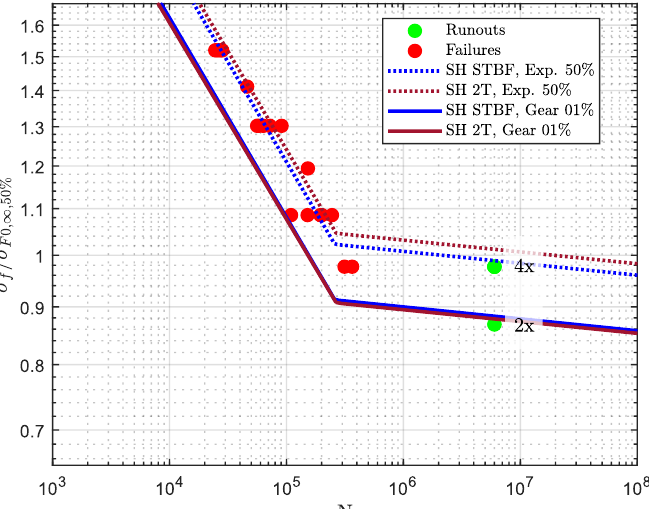
Figure 8. Evaluation of SN curves with different failure probabilities for exemplary campaign A from the experimental FZG database [24] according to the ML&SoE approach [27,28].